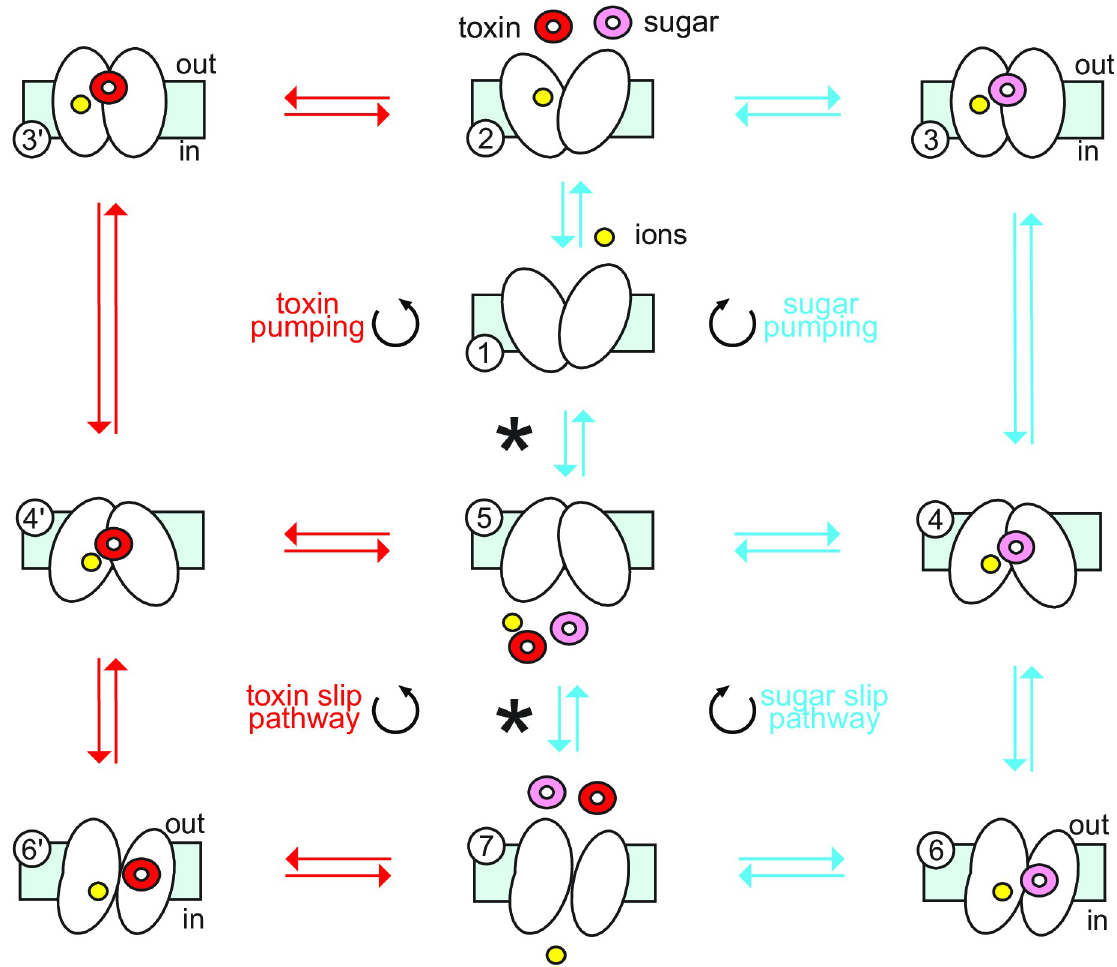
Fig 3. Kinetic model of substrate and toxin transport with slip. The slip mechanism, represented in the lower cycles, includes an inward- open conformation with a partially-open outer gate (states 6, 6’, 7) corresponding to states in Fig 1. Transitions from 6 or 6’ to 7 involve the Na + entering the cell going down its energy gradient, while the toxin (red molecule) or sugar (pink) escape to the extracellular space. The right set of states (blue transitions) all involve sugar movement, the left states (red) involve toxin movement, while the upper states are based on the canonical pumping cycles in Fig 2A. All toxin transport states are identically mirrored based on corresponding sugar states, but rate constants have been modified as discussed in the text. Additionally, the full outer cycles on the right and left are Na + leak cycles that move the ion down its gradient. Note that the 5 to 7 transition indicated by an asterisk is a conformational change that does not involve substrate movement. The cycles and pumping definitions for sugar are explained in S1